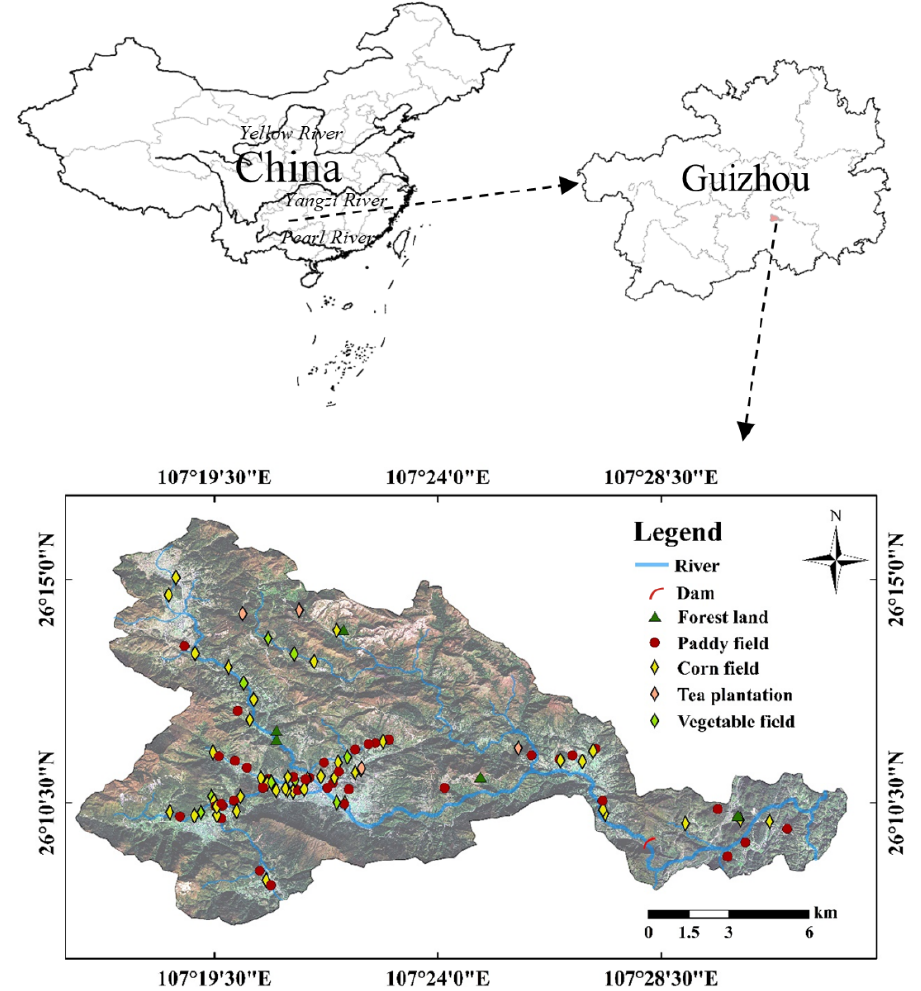
Figure 1. Sampling locations in the Caidi River Watershed, Guizhou Province.